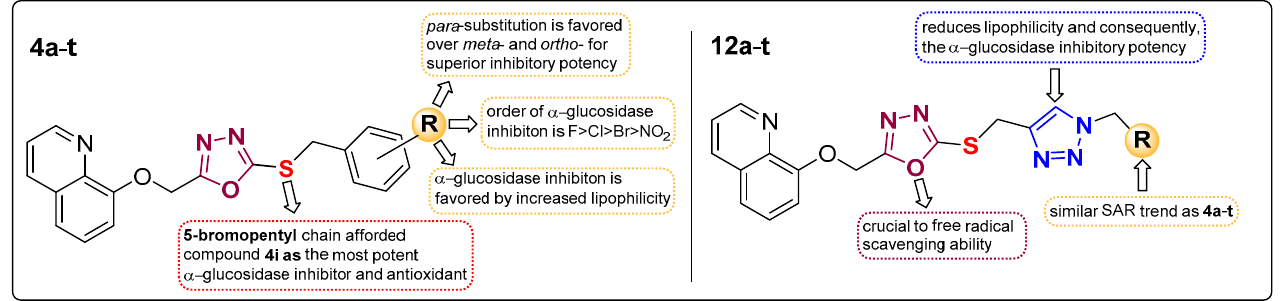
Figure 3. SAR summary of α -glucosidase inhibition and antioxidant activity.